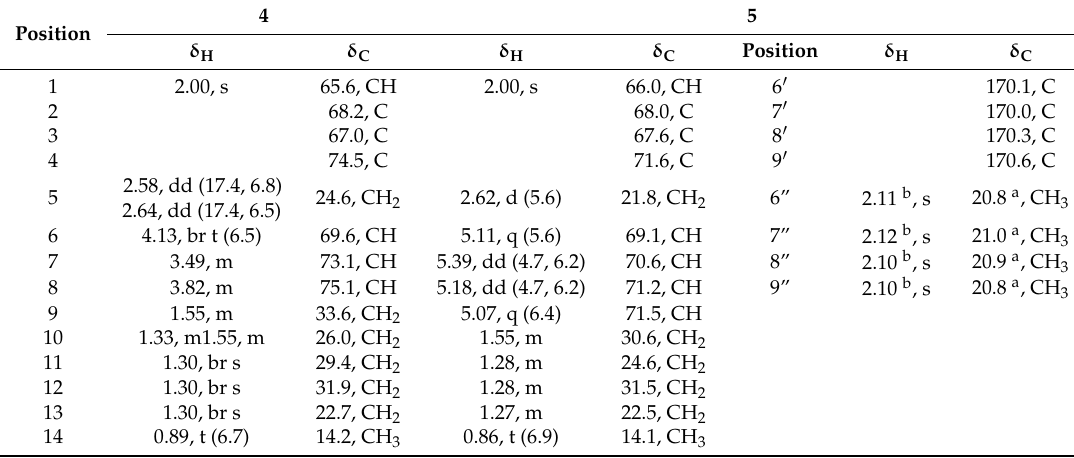
Table 2. 1 H (500 MHz) and 13 C-NMR (125 MHz) data for compounds 4 and 5 in CDCl 3 ( δ in ppm, J in Hz).